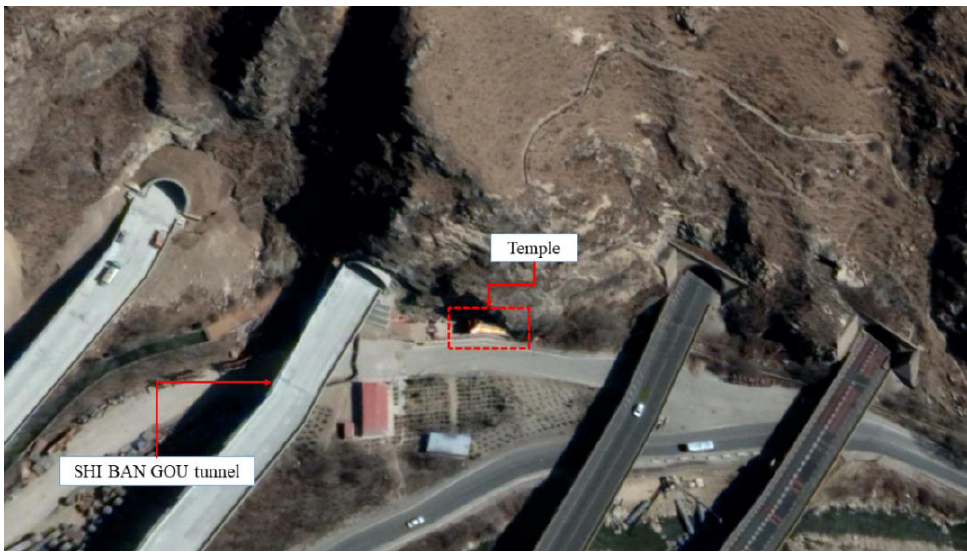
Figure 2. Route map of the tunnel (via Google Earth Pro).